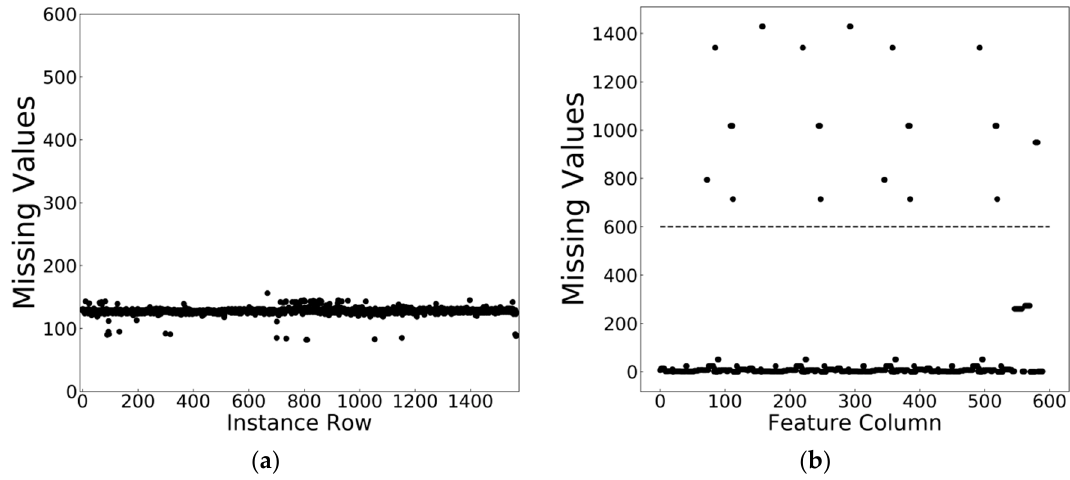
Figure 2. Number of missing data points in: ( a ) Each instance; ( b ) Each feature.